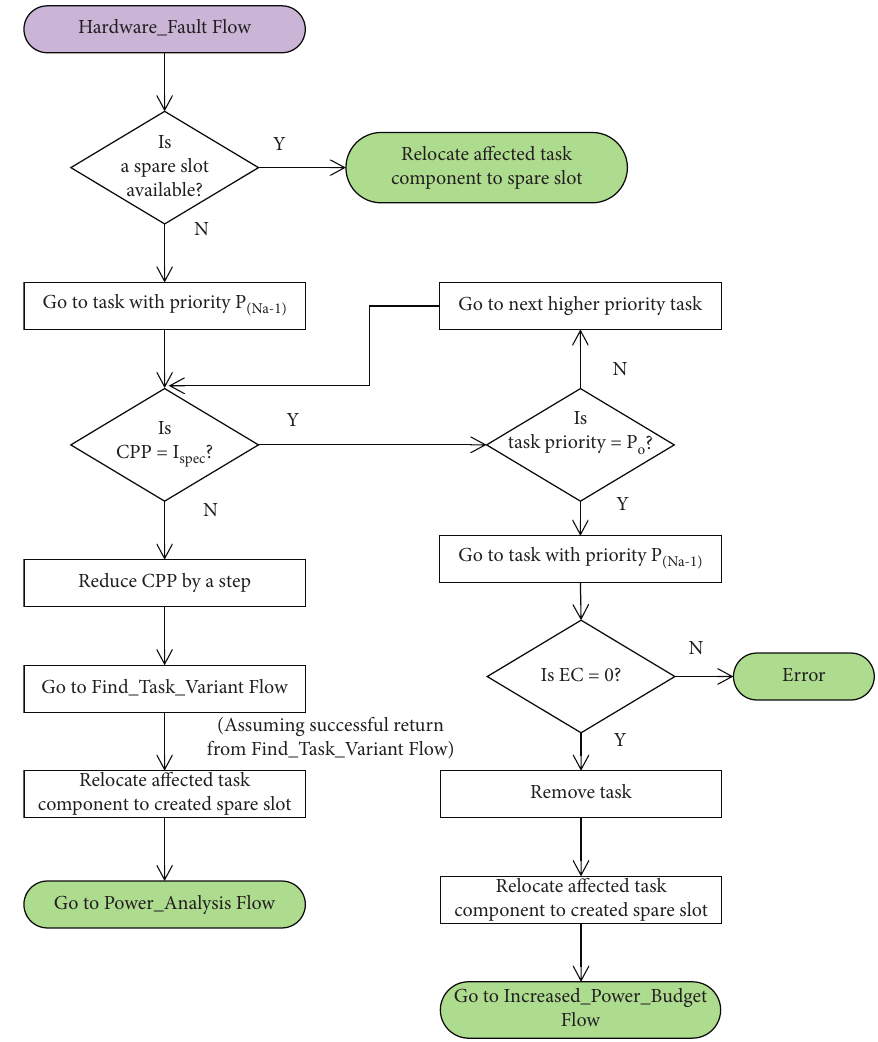
Figure 11: Hardware_Fault flow of Explorer.